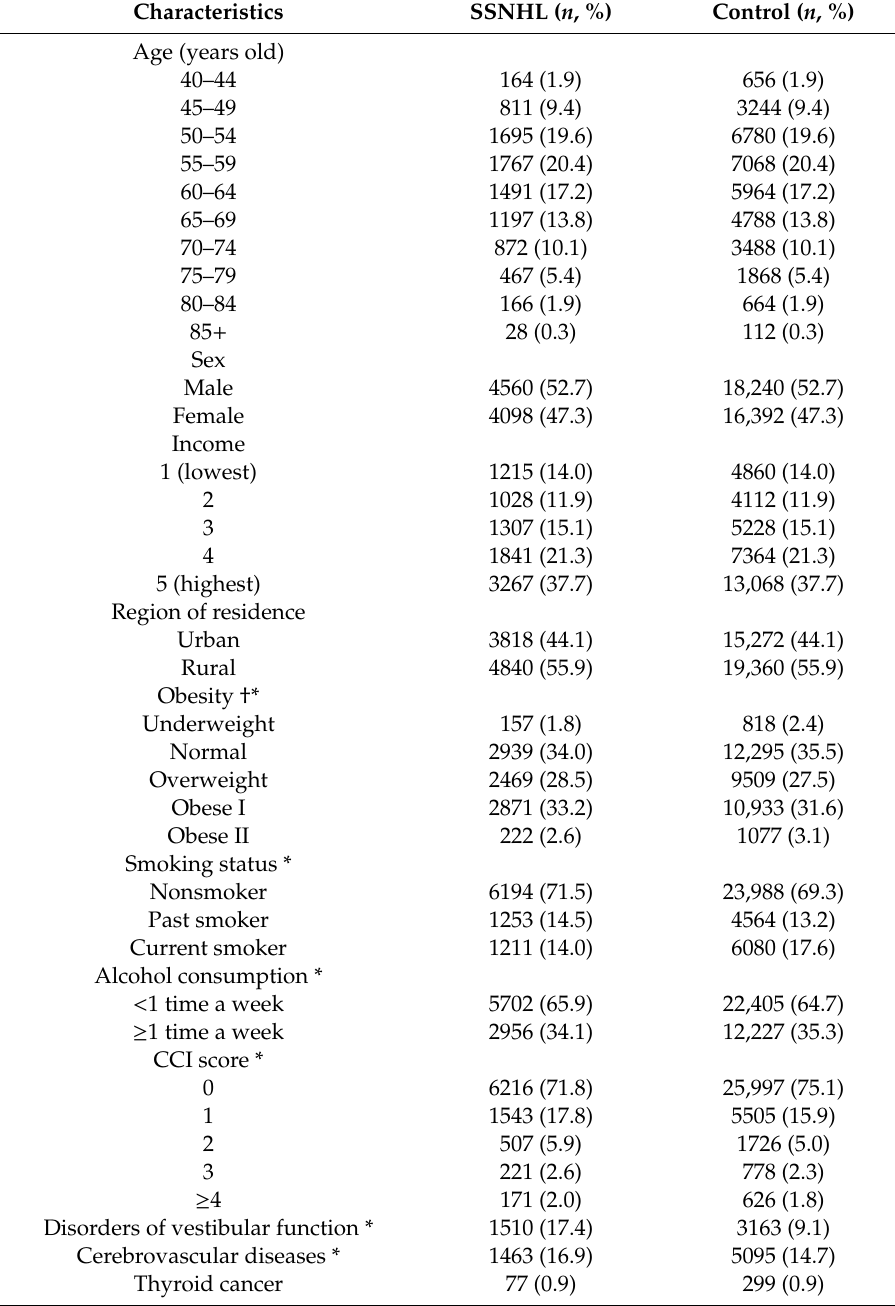
Table 1. General Characteristics of